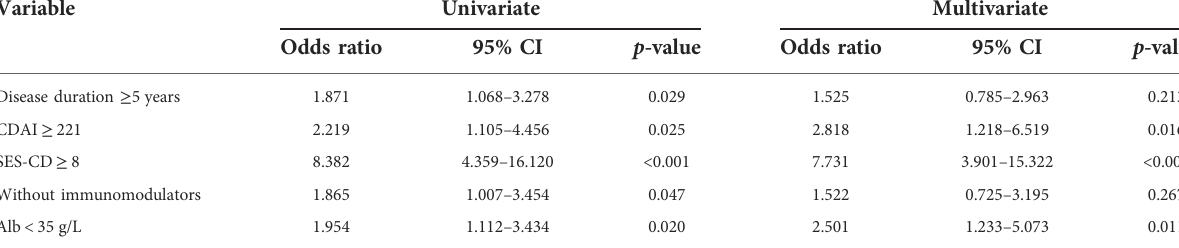
TABLE 5 Multivariate logistic regression analysis of risk factors for intestinal obstruction in CD patients.